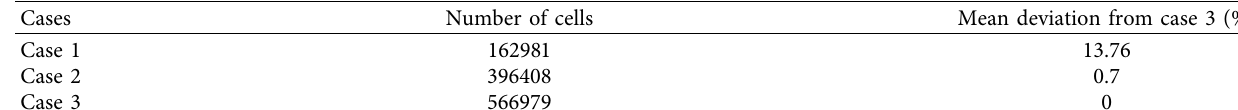
Table 1: Mesh independency study.